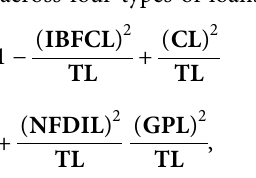
Table 1: Sampled countries with their average IDV, NIM, and